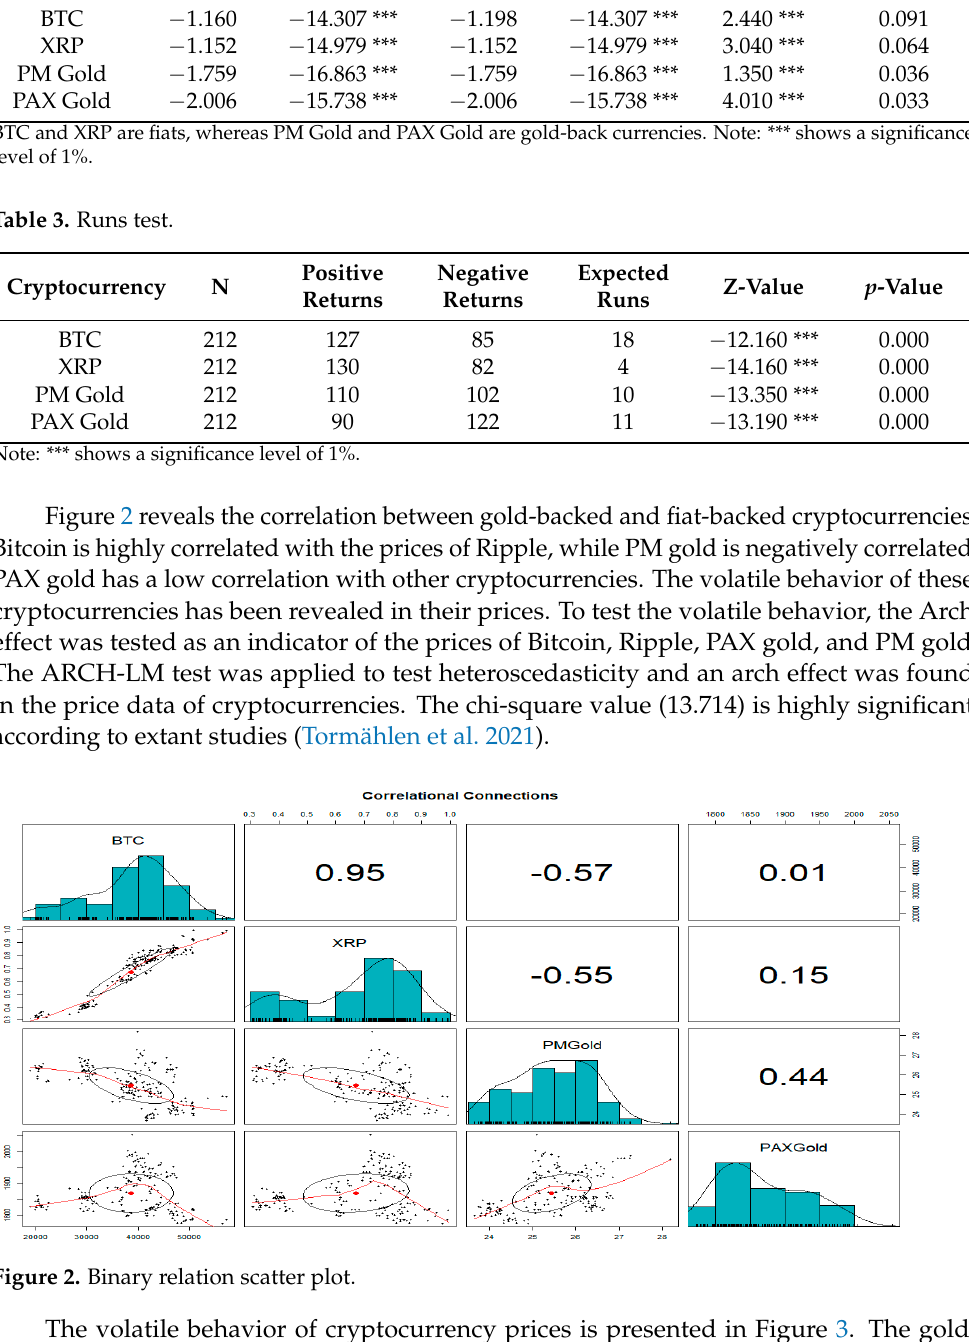
Table 2. Unit root test.